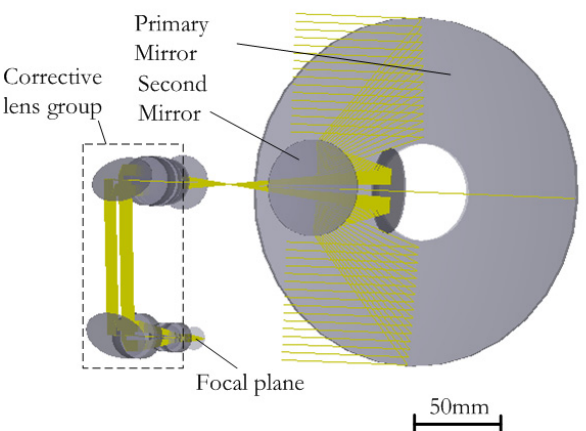
Figure 1. Optical model of the visible light camera.